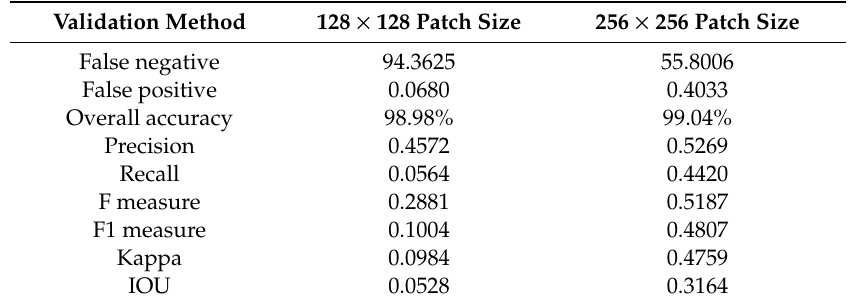
Table 4. The accuracy of a 128 × 128 patch size compared with a 256 × 256 patch size on the Bangkok testing